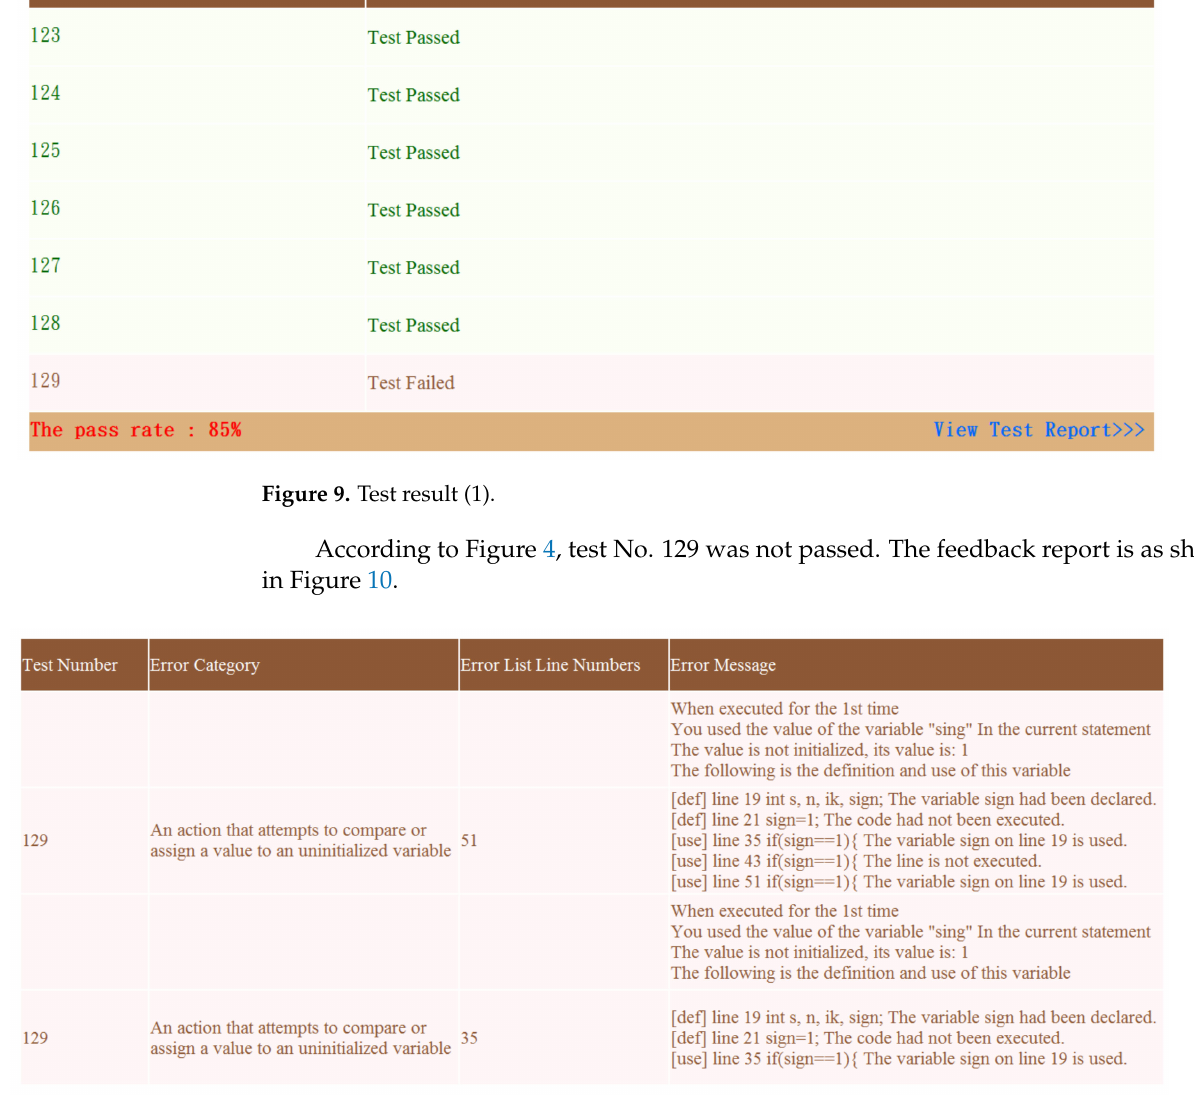
Figure 10. Feedback report